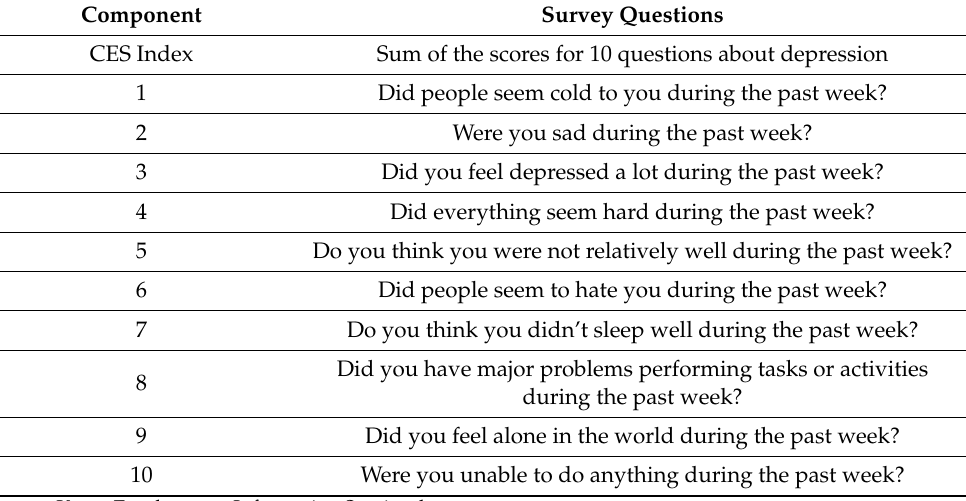
Table 1. Survey questions used to measure the Center for Epidemiological Studies (CES) index.